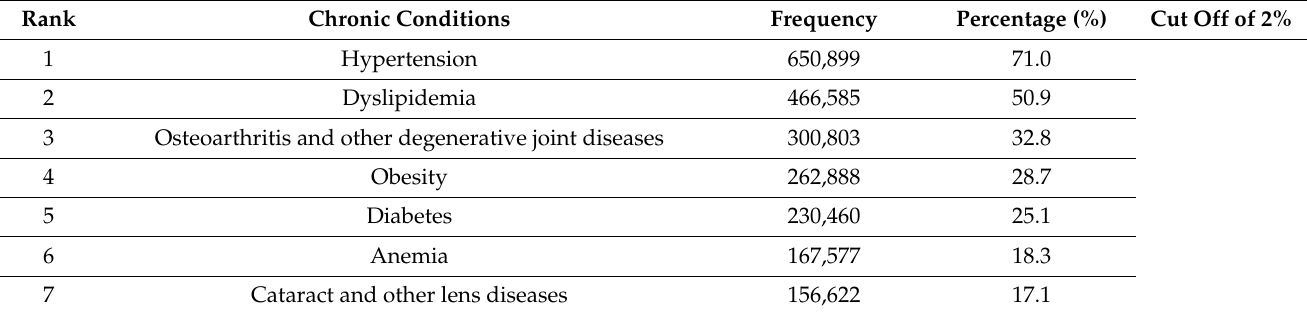
Table A1. Prevalence of the 60 chronic diseases included in the study in individuals aged 65–99 years ( n = 916,619, Catalonia, 2012). In the last column, list of diseases included by prevalence cut off of